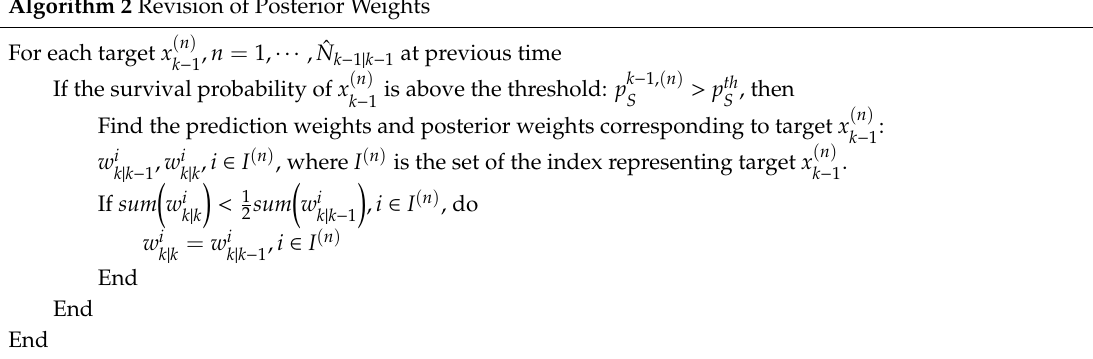
Algorithm 2 Revision of Posterior